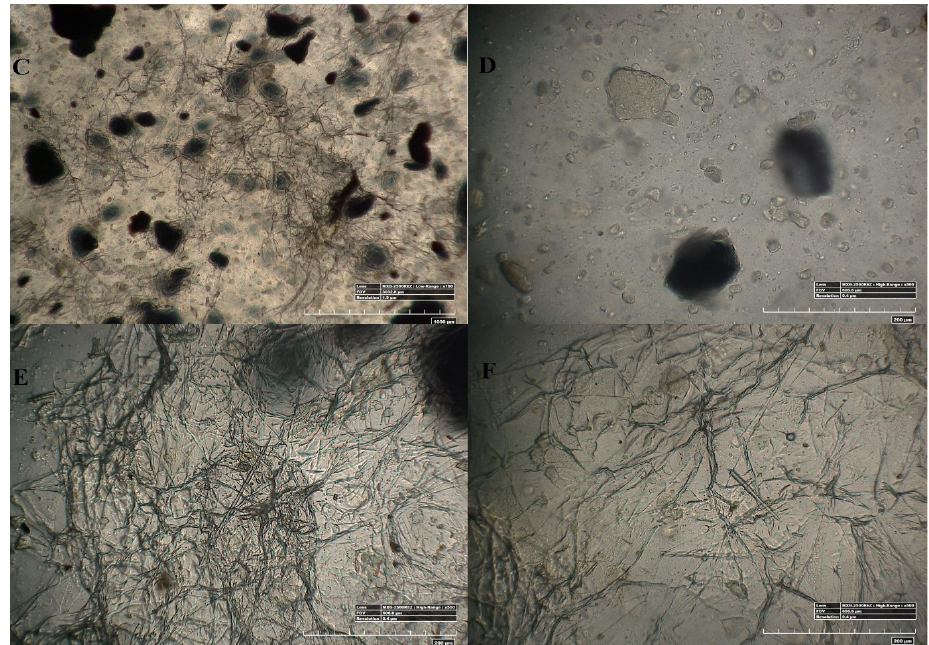
Figure 4. 100× and 500× image using 3D Hirox digital microscopy. ( A – C ) are the 100× image of pristine mPE ‐ nHA, 12 h Aloe vera dip ‐ coated mPE ‐ nHA and 24 h Aloe vera dip ‐ coated mPE ‐ nHA nanocomposite, respectively; ( D – F ) are the 500× images of untreated mPE ‐ nHA, 12 h Aloe vera dip ‐ coated mPE ‐ nHA and 24 h Aloe vera dip ‐ coated mPE ‐ nHA nanocomposite, respectively.